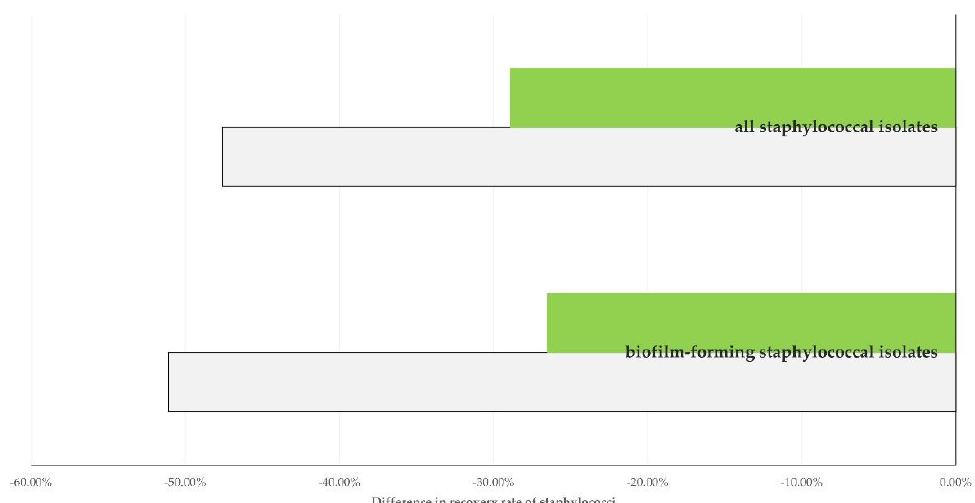
Figure 3. Difference in isolation rate of staphylococci from farm bulk-tank milk from sheep flocks (green) or goat herds (grey) in Greece, in which vaccination against staphylococcal mastitis was applied, compared to farms, in which no such vaccination was performed.